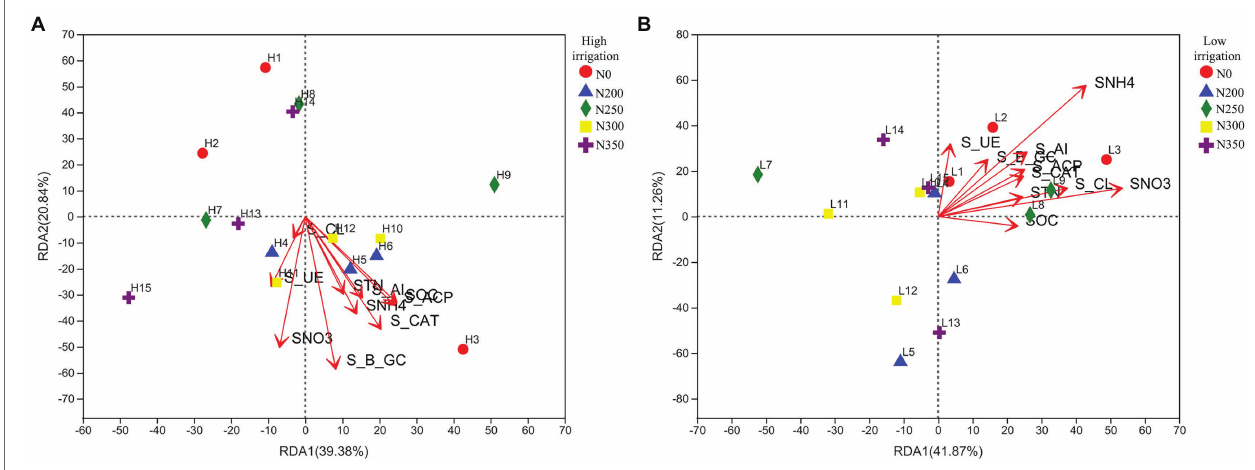
FIGURE 4 | Redundancy analysis of different zones, abundant classes, and ten environmental factors (arrows) indicates the dominant communities and influential environmental factors in the soil under low irrigation (A) , and high irrigation (B)